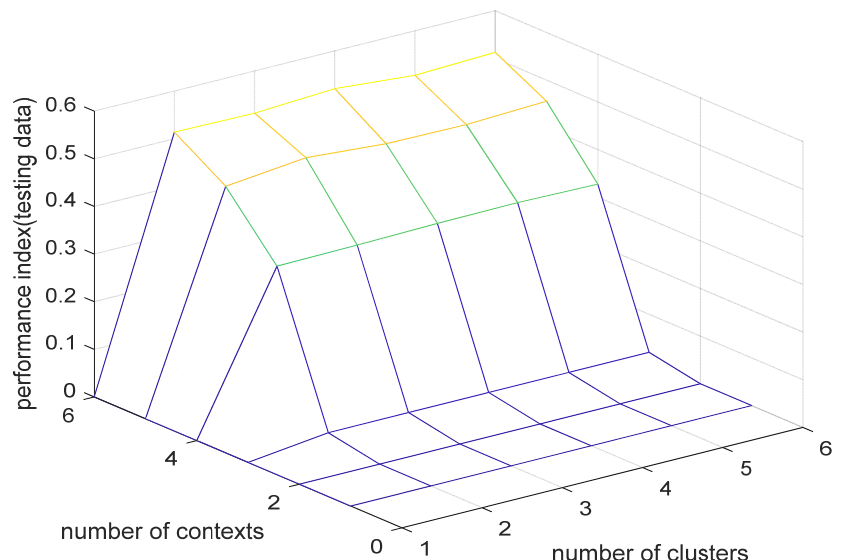
Figure 11. Comparison between the output of the CGK-based fuzzy granular model of the aggre- gated structure and the real output (uniform generation of contexts, number of contexts = 6, number of clusters = 4).